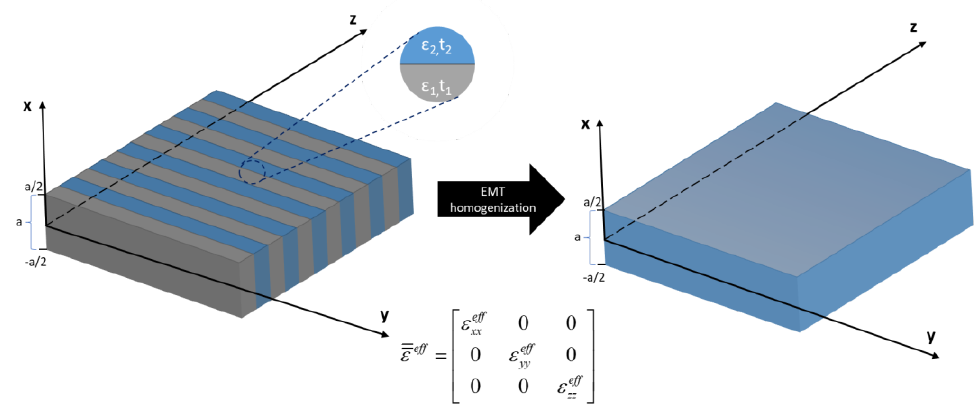
Figure 1. Schematic representation of HMM waveguide core layer homogenization.